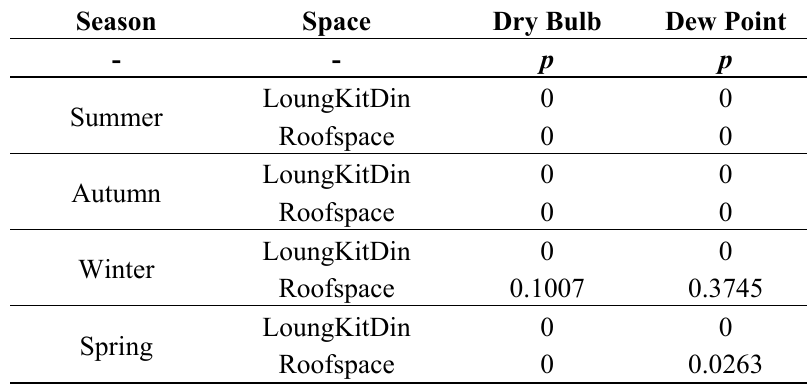
Table 6. Summary of statistical significance of differences between control and test